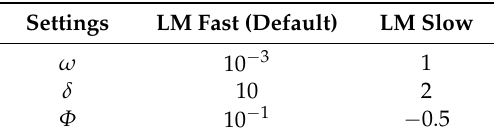
Table 1. Levenberg–Marquardt (LM) training algorithm